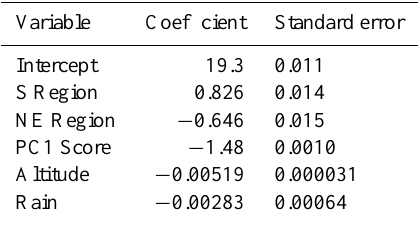
Table 4. Regression model for maximum daily temperatures ( ◦